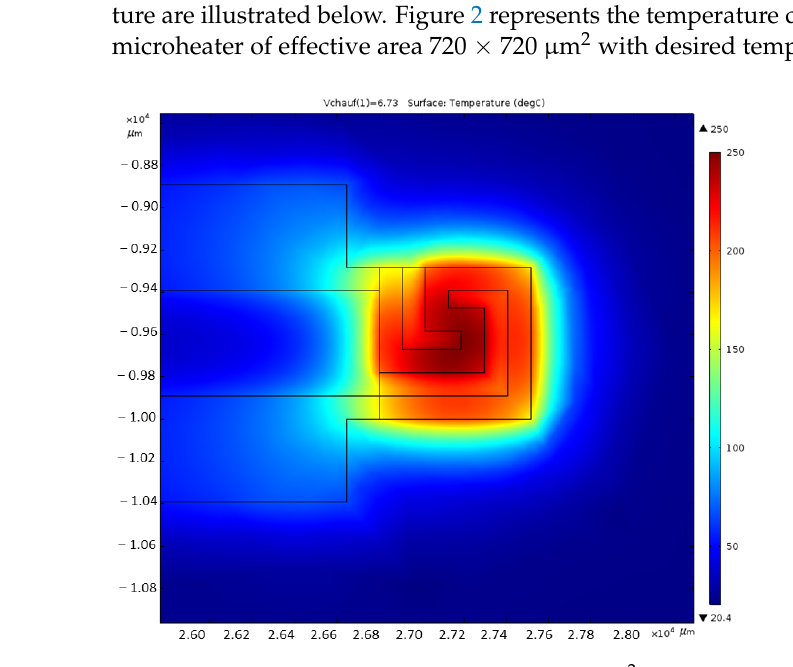
Figure 2. Temperature Distribution in 720 × 720 µ m 2 silver microheater at 6.73 V.